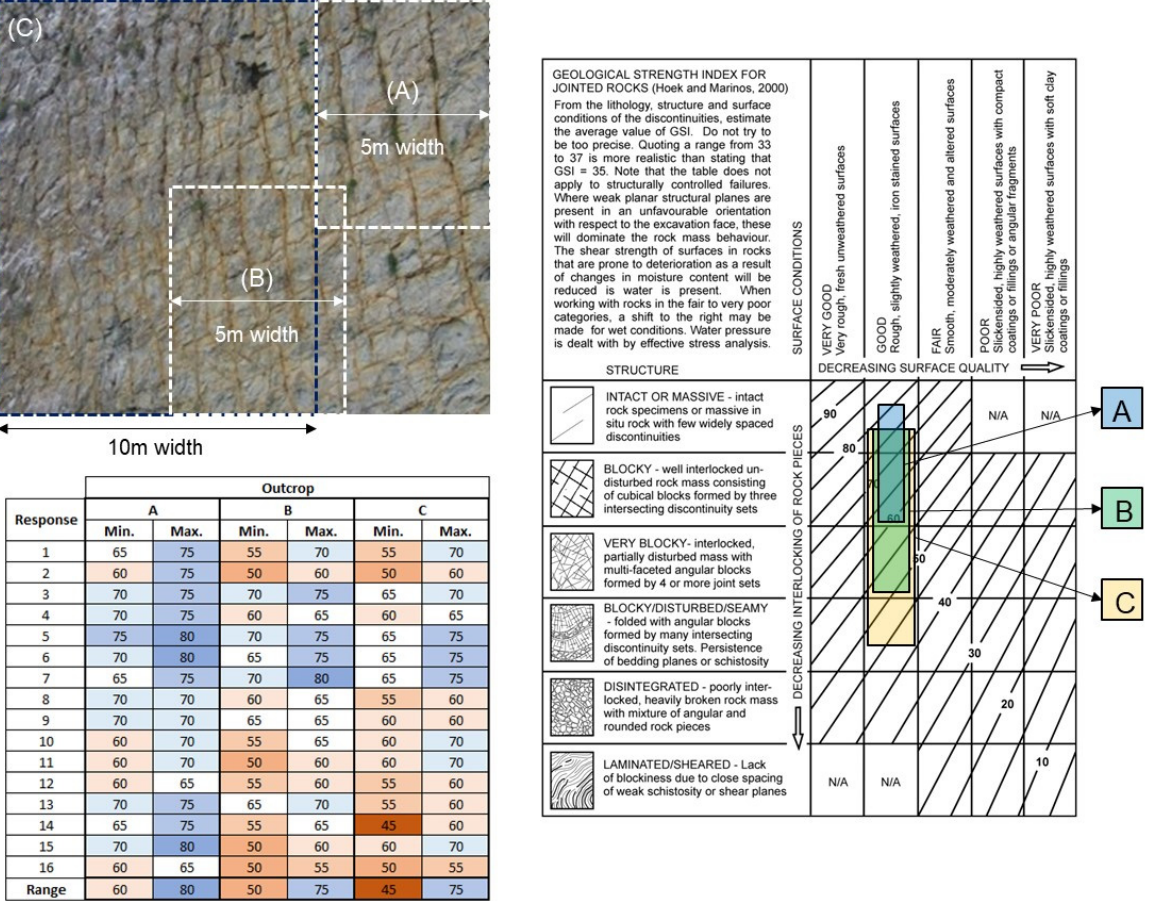
Figure 10. Results of the survey analysing the subjectivity of the processes by which different persons would determine the GSI of the three—only apparently different—rock outcrops.